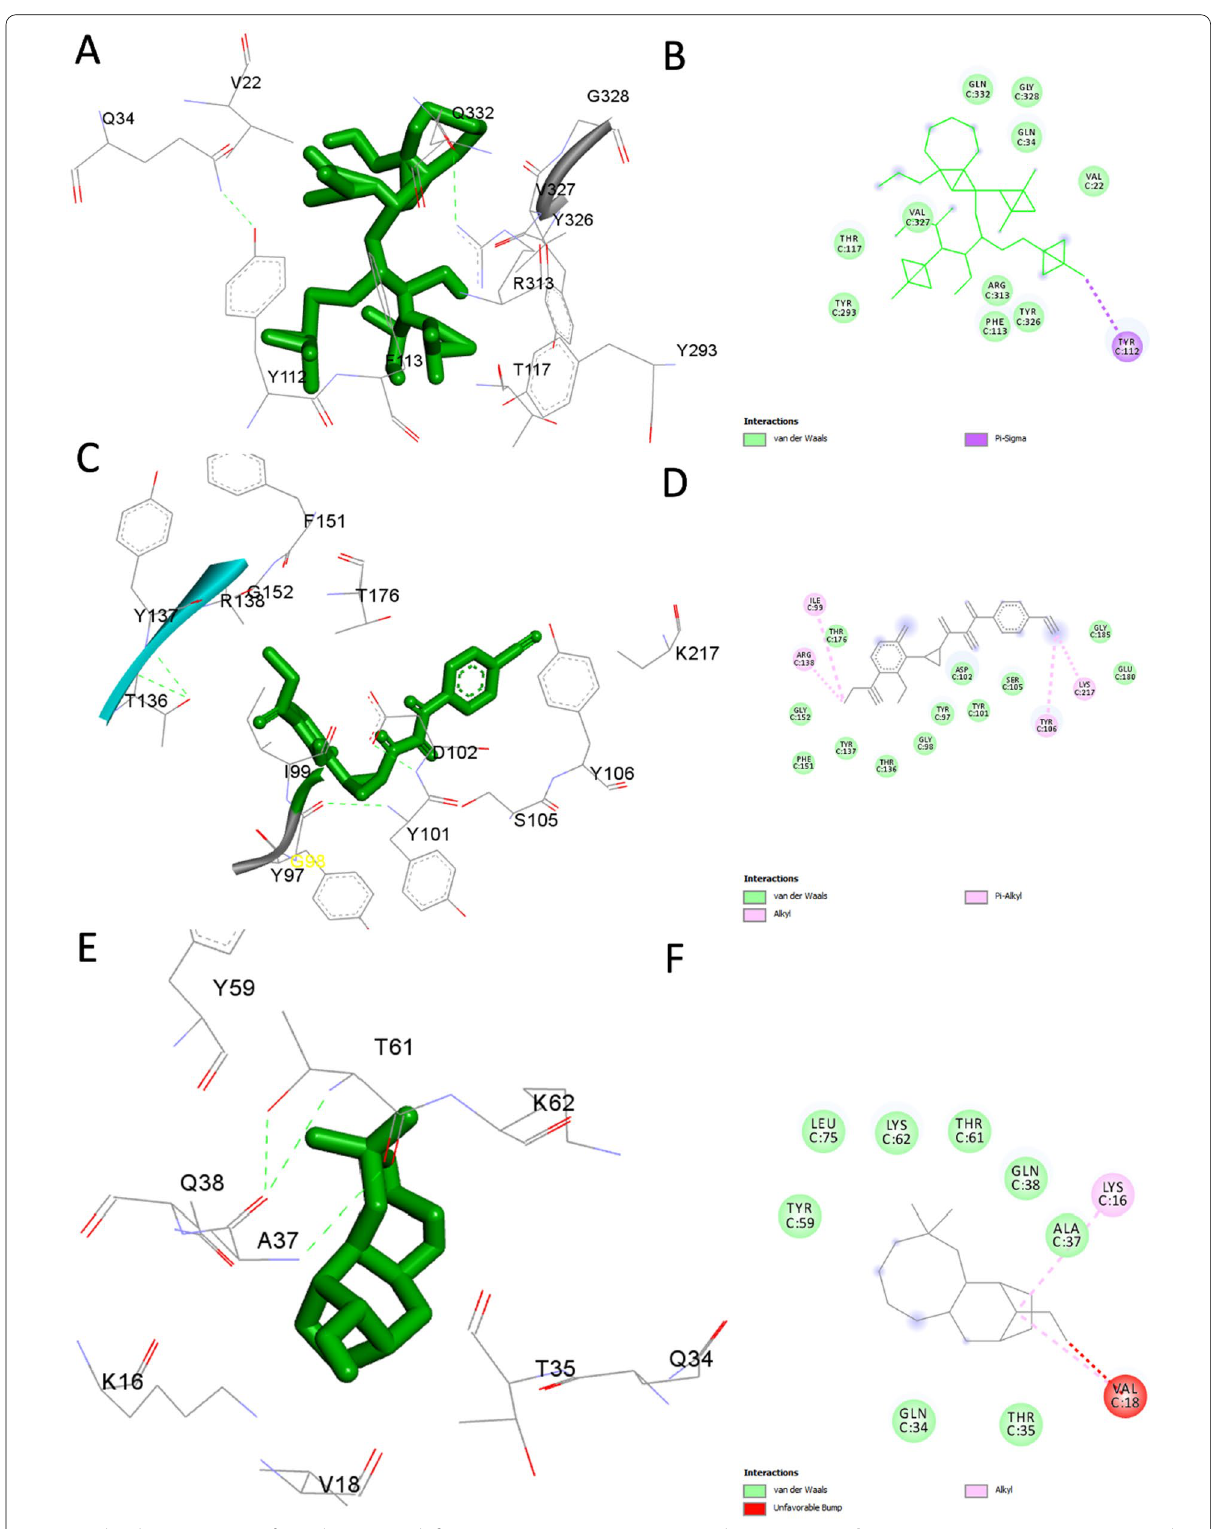
Fig. 4 Molecular interactions of S. typhi OmpF with ß-carrageenan 3D interaction ( a ) and 2D interaction ( b ); α-carrageenan 3D interaction ( c ) and 2D interaction ( d ); λ-carrageenan 3D Interaction ( e ) and 2D interaction ( f